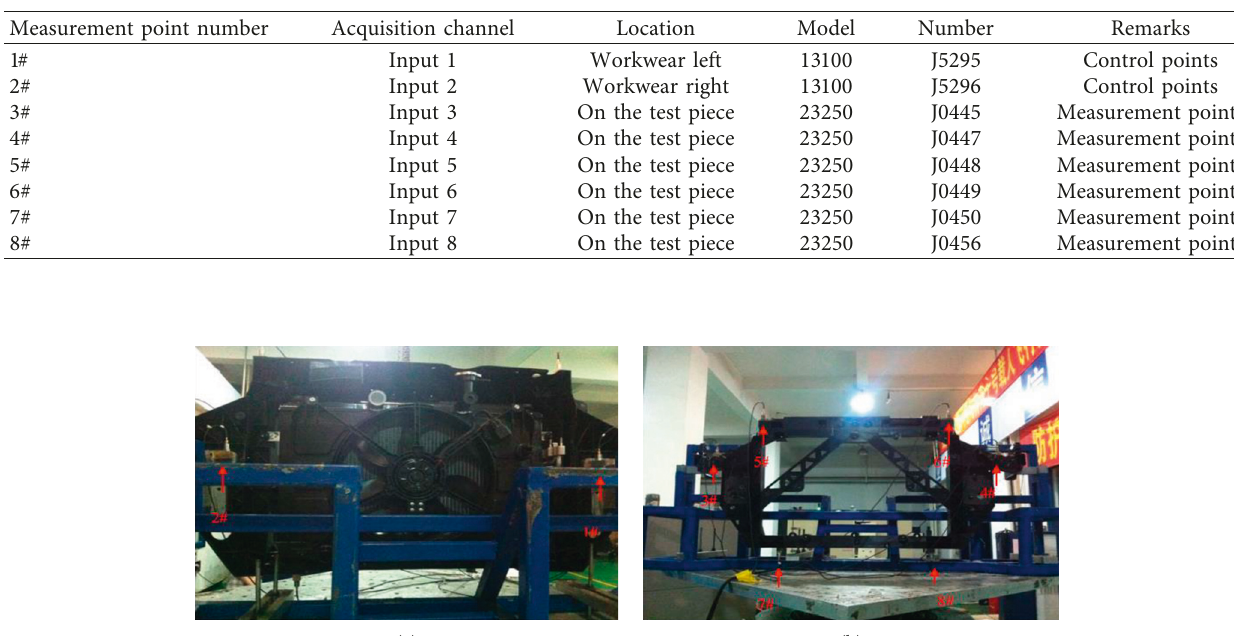
Table 8: Test piece measurement points.